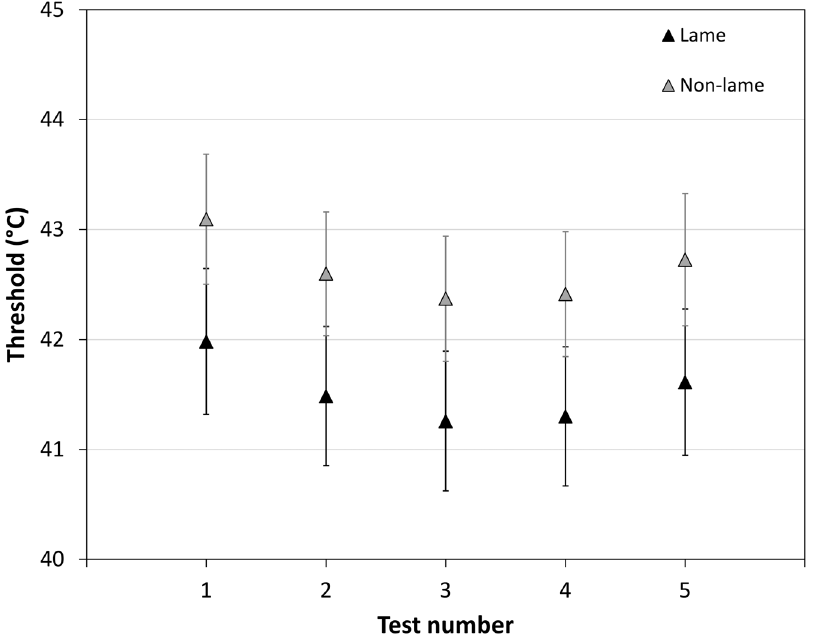
Figure 1. Effect of test number on threshold. For lame and non-lame birds, the modelled predictions ( + / 2 95% CI) of the effect on thermal nociceptive threshold of test number (keeping other factors in the model at their reference values).